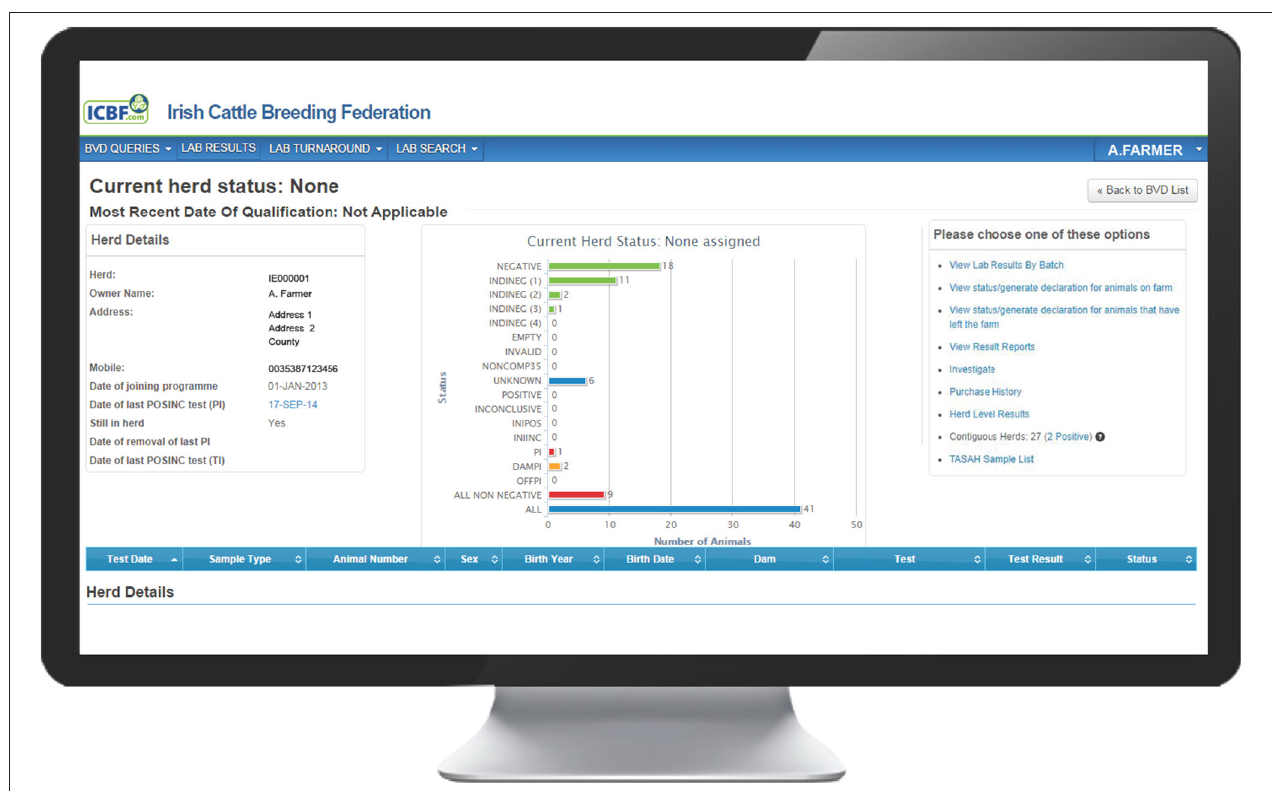
FIGURE 1 | Landing page on the BVD herd-level dashboard provided by ICBF, summarising the current status of all animals in the herd and providing a series of additional options.